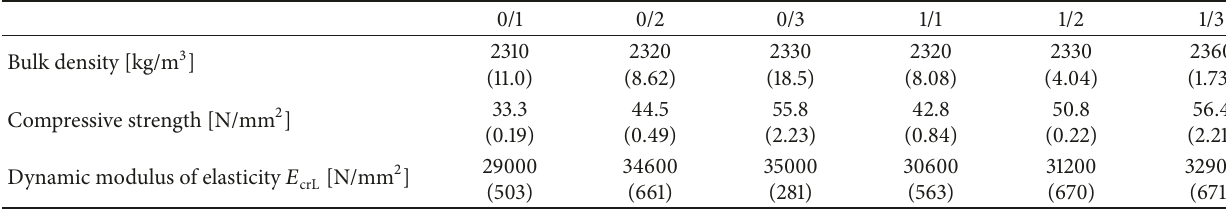
Table 4: Basic characteristics of hardened concretes.